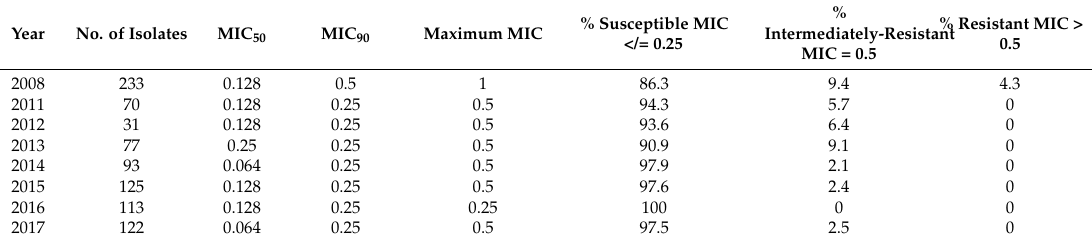
Table 5. Azithromycin MIC trend analysis, Johannesburg, 2008–2017.